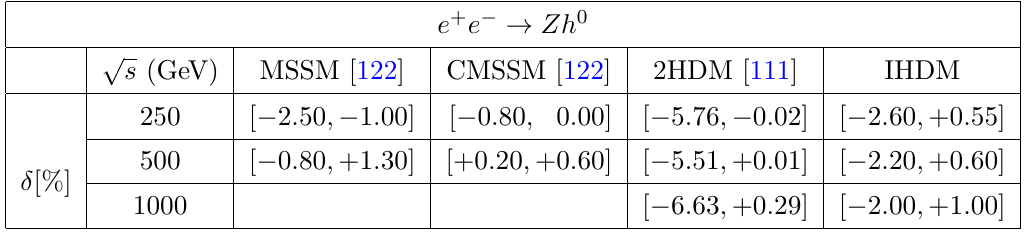
Table 7 . The ranges of the size of radiative corrections for e + e − → Zh 0 for different SUSY and non-SUSY models are